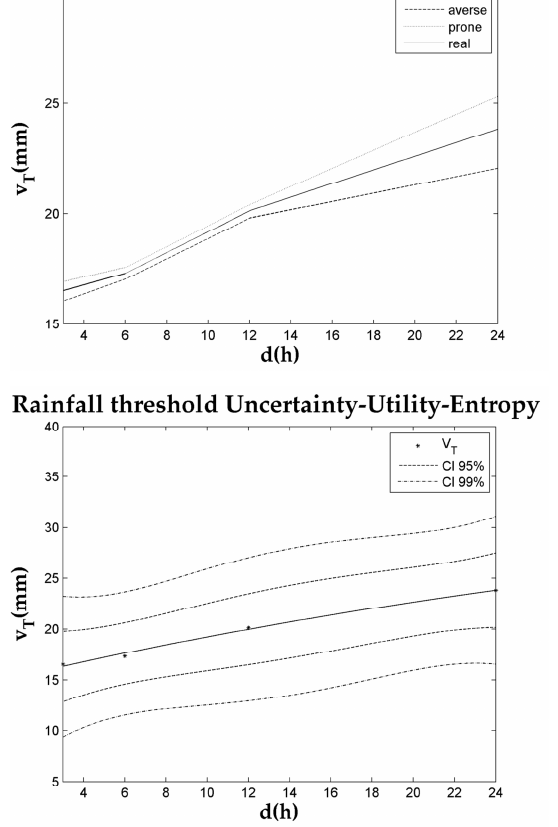
Fig. 6. Threshold values evaluated via the utility-entropy mea- sure of risk approaches ( λ = 0 . 5) for the Mignone River basin: “real” case (solid line), “prone” case (dotted line) and “averse” case (dashed line) for AMCIII soil condition (upper panel) and uncer- tainty associated with “real” case AMCIII threshold (lower